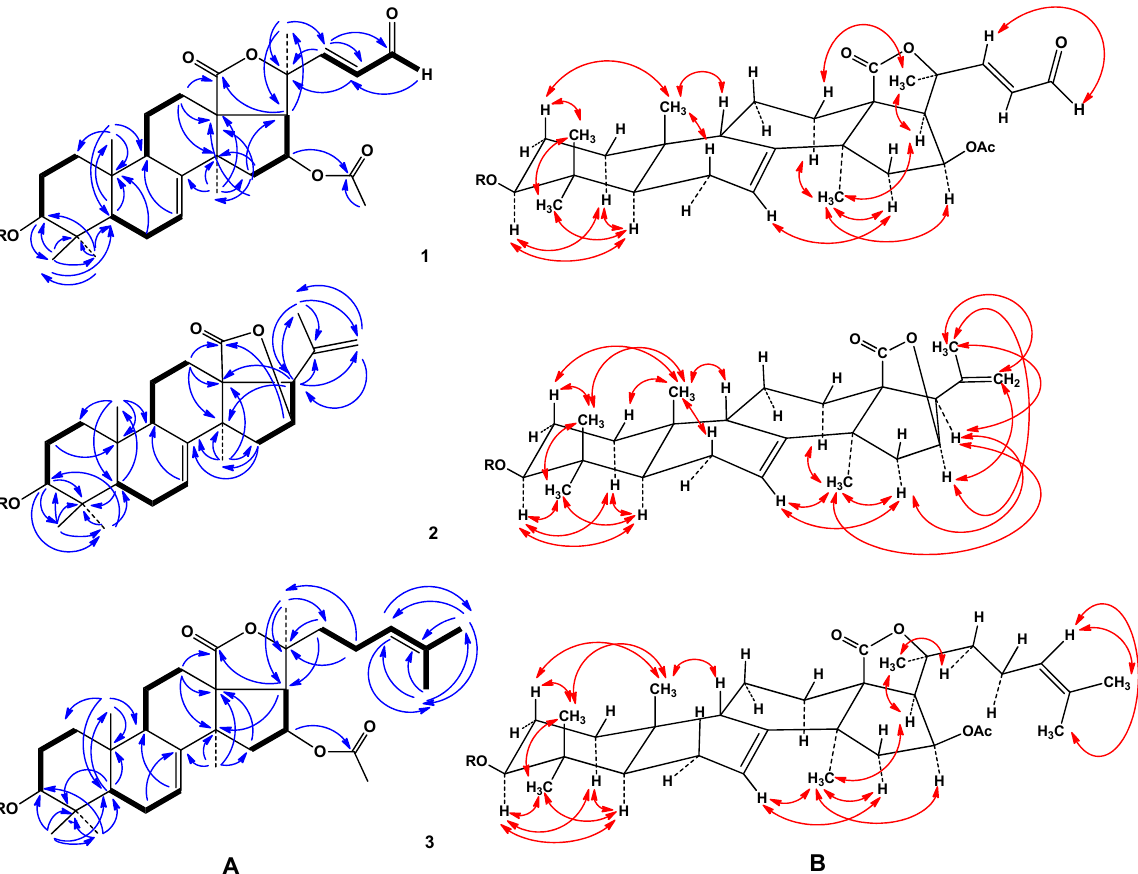
Figure 2. ( A ) 1 H- 1 H COSY and key HMBC correlations for aglycon part of compounds 1–3. ( B ) Key ROESY correlations for aglycon part of compounds 1–3.